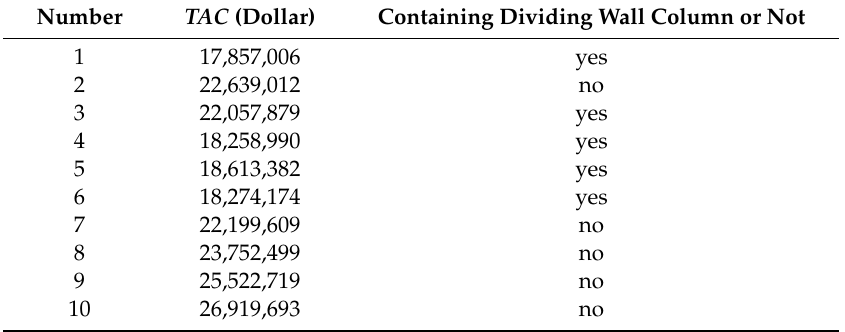
Figure 7. The optimal sequence of the four-component alkane case with 17,857,006 dollars TAC . Table 6. The costs of sharp sequences of the four-component alkane case. TAC = total annual cost. Number TAC (Dollar) Containing Dividing Wall Column or